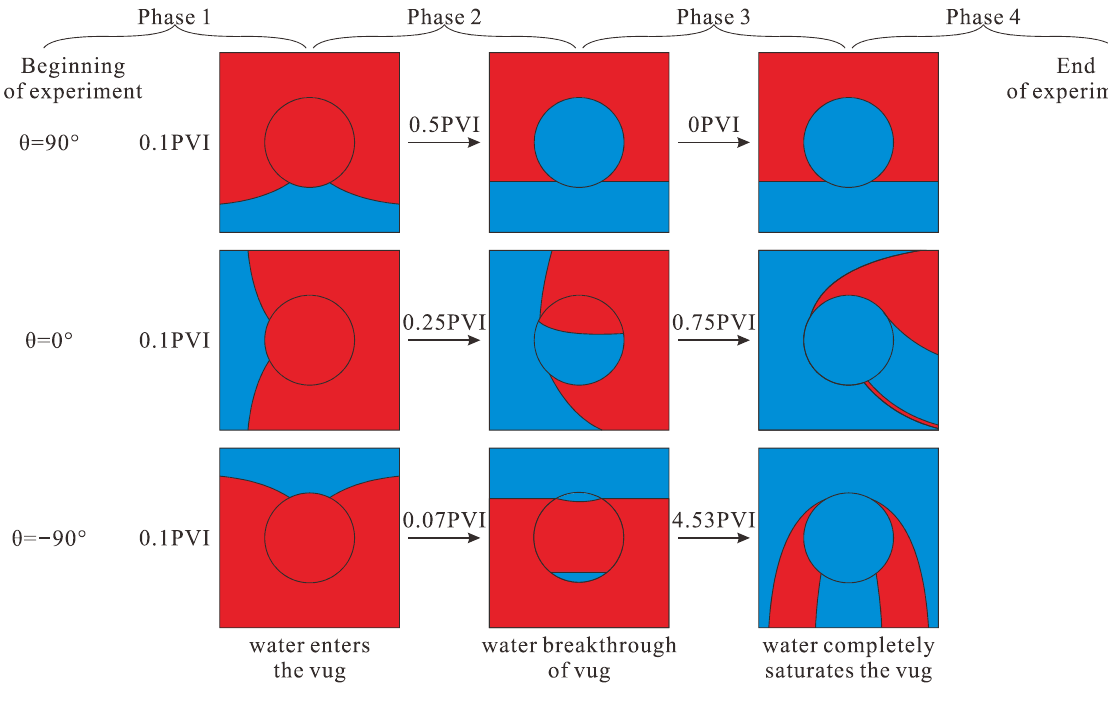
Figure 9. The four distinct phases of the displacement process during the displacement experiment in the single-vug model in downward ( θ = − 90°), horizontal ( θ = 0°), and upward ( θ = 90°) direction.